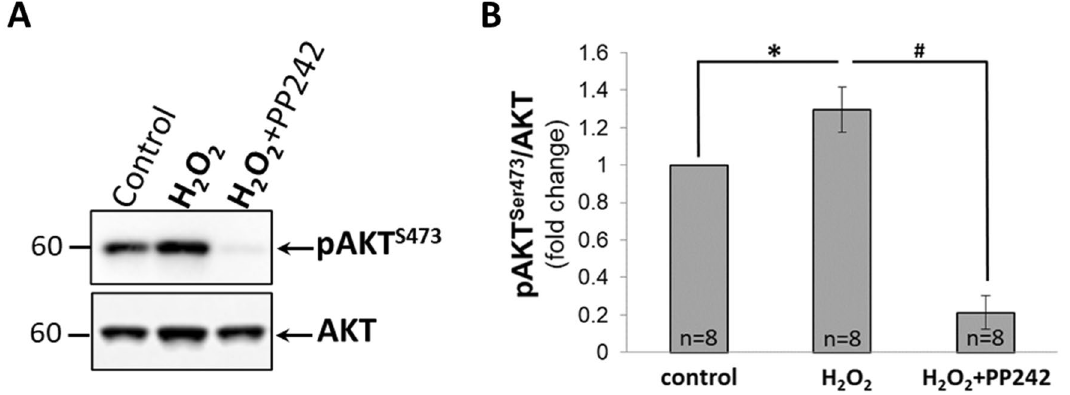
Figure 4. ( A ) Representative Western Blot of total AKT and phosphorylated AKT (pAKT Ser473 ) in mTAL isolated from SD rats. mTAL incubated in HBSS for 20 min ( control ); incubated 10 min in HBSS and then with 100 µM of H 2 O 2 for another 10 min ( H 2 O 2 ); incubated with 10 µM of PP242 for 10 min and then with 100 µM of H represented as mean ± S.E.M (n = 8). * P < 0.05 between control and H 2 O 2 treated mTAL; # P < 0.05 between H 2 O 2 treated and H